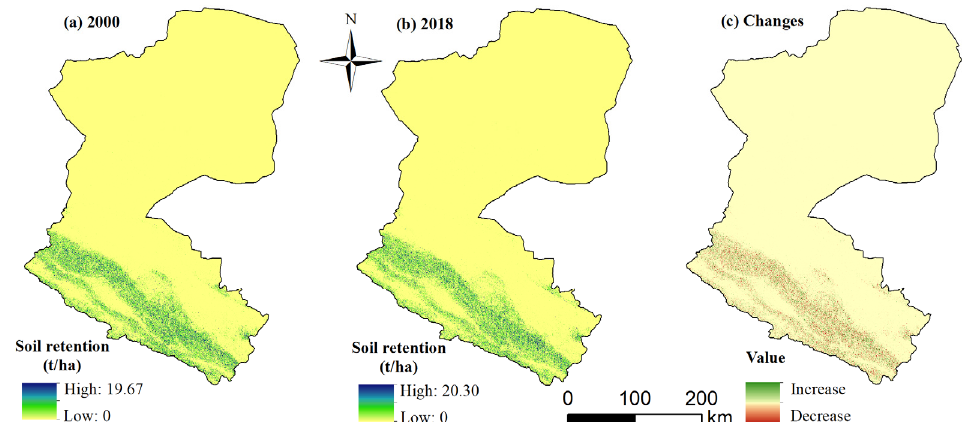
Figure 6. Spatial distribution and changes in soil retention from 2000 to 2015 ( a ): soil retention in 2000; ( b ): soil retention in 2015; ( c ): changes from 2000 to 2015).